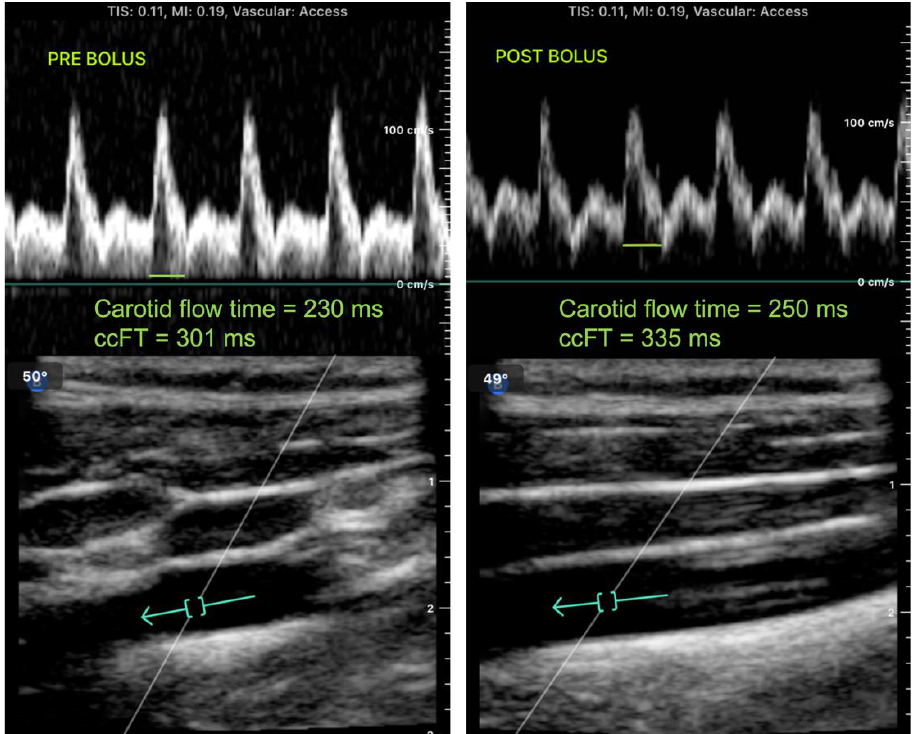
Figure 2. Spectral Doppler tracing ( top ) showing the measurement of carotid flow time intraoperatively on a patient using portable handheld ultrasound before ( left panel ) and after ( right panel ) a 250 cc fluid bolus. The arrows ( bottom ) show the measurement location of the Doppler tracing. The systolic flow time at the common carotid artery was corrected for heart rate based on Wodey’s formula to determine a corrected carotid flow time (ccFT) of 301 ms before a fluid bolus and 335 ms after a fluid bolus, suggesting that this patient is fluid-responsive and may benefit from continued fluid administration.